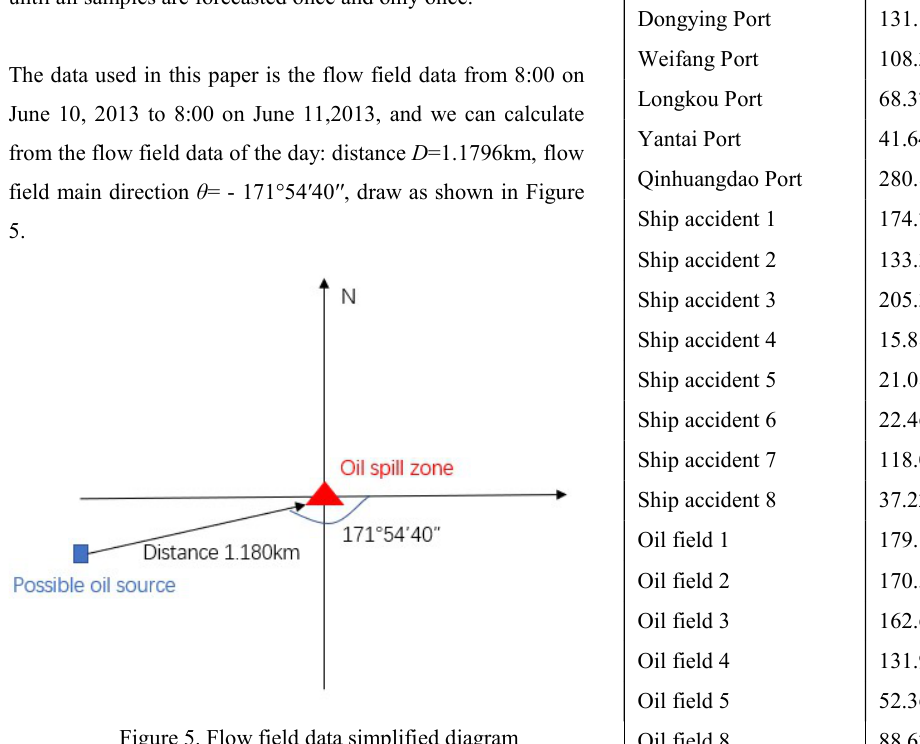
Figure 5. Flow field data simplified diagram